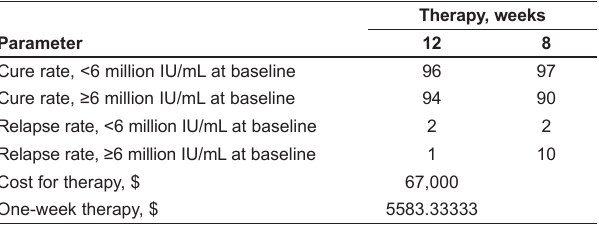
TABLE 1 Input values used to generate models